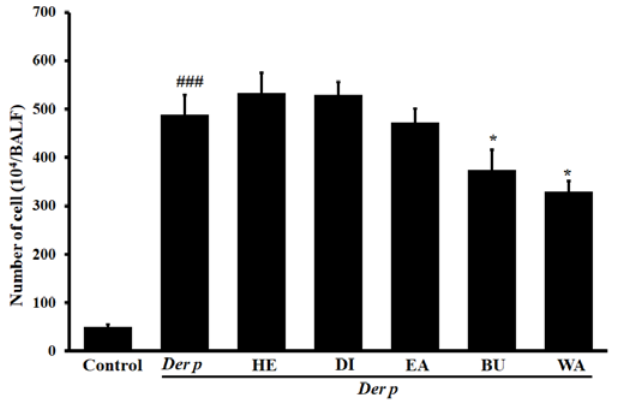
Figure 1. Effects of different fractions of garlic extracts (80 mg/kg) on the total inflammatory cell count in the collected bronchoalveolar lavage fluid (BALF) of mice with Der p–induced allergic asthma. Data derived are presented herein as mean ± SEM. ### p < 0.001 versus the control group, * p < 0.05 versus the Der p group.